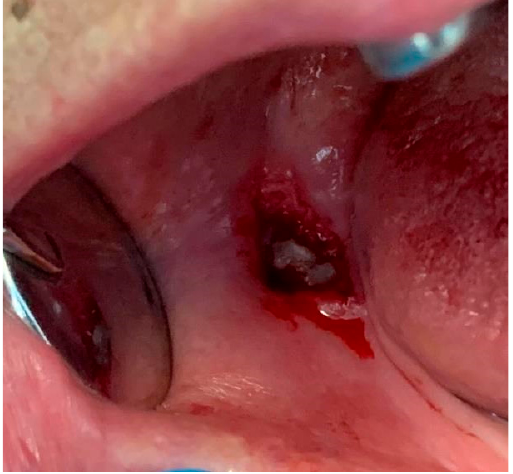
Figure 4. The affected area after the operculectomy.